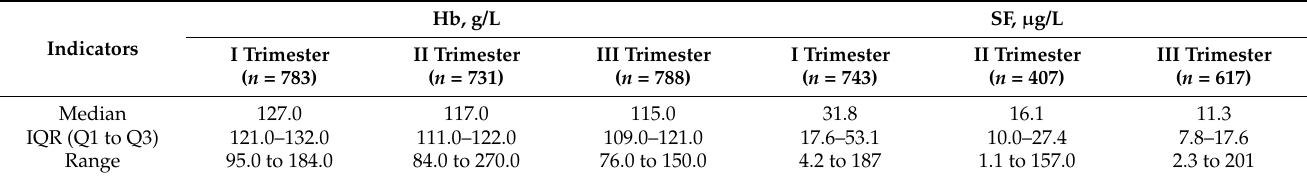
Table 1. Levels of Hb and SF in the three trimesters of pregnancy.